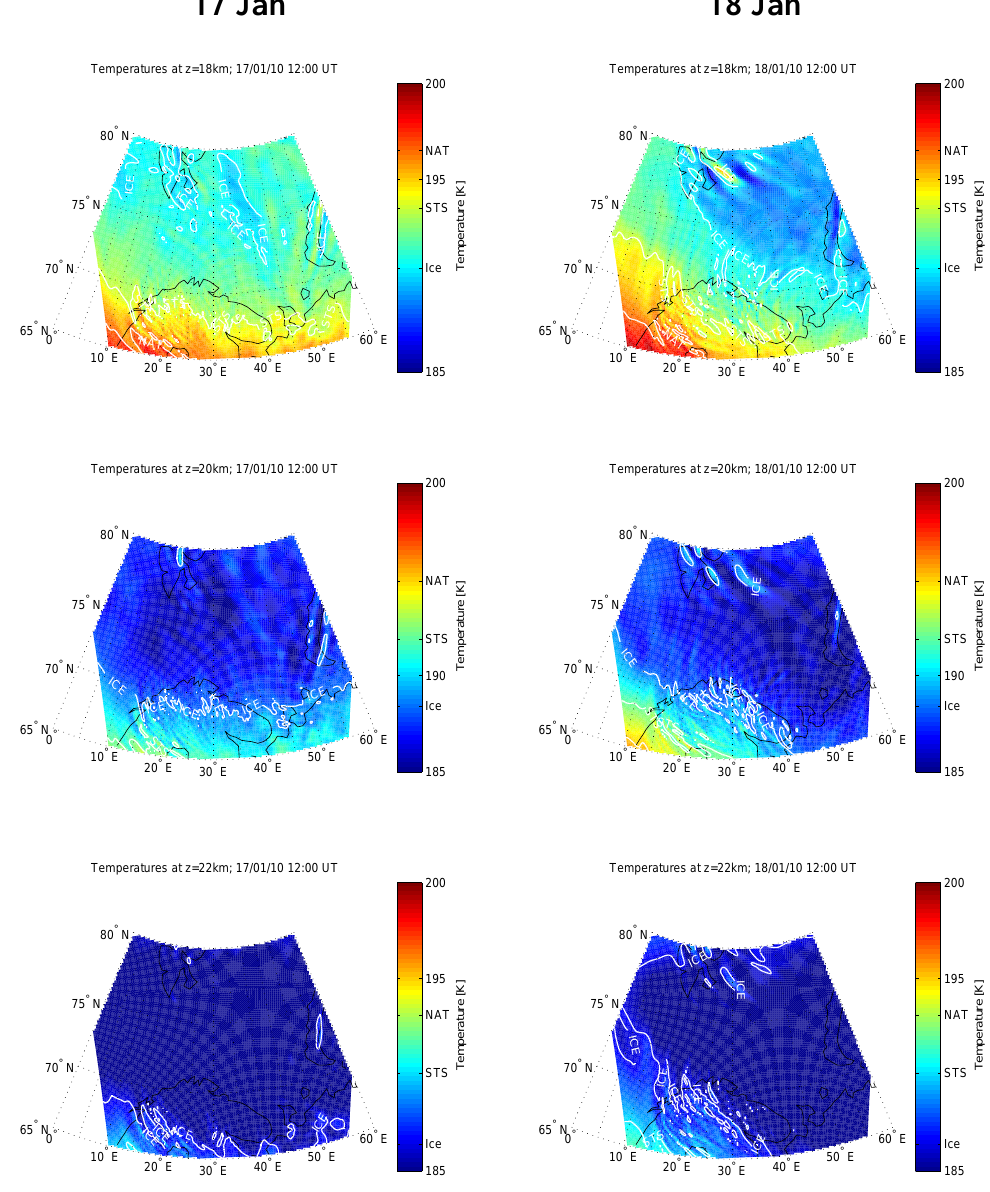
Fig. 10. Temperatures simulated with WRF on 17 (left column) and 18 January 2010 (right column) 12:00UT at 18 (top), 20 (middle) and 22km (bottom). The white lines indicate the areas where ice, STS and NAT formation temperatures, respectively, are reached.